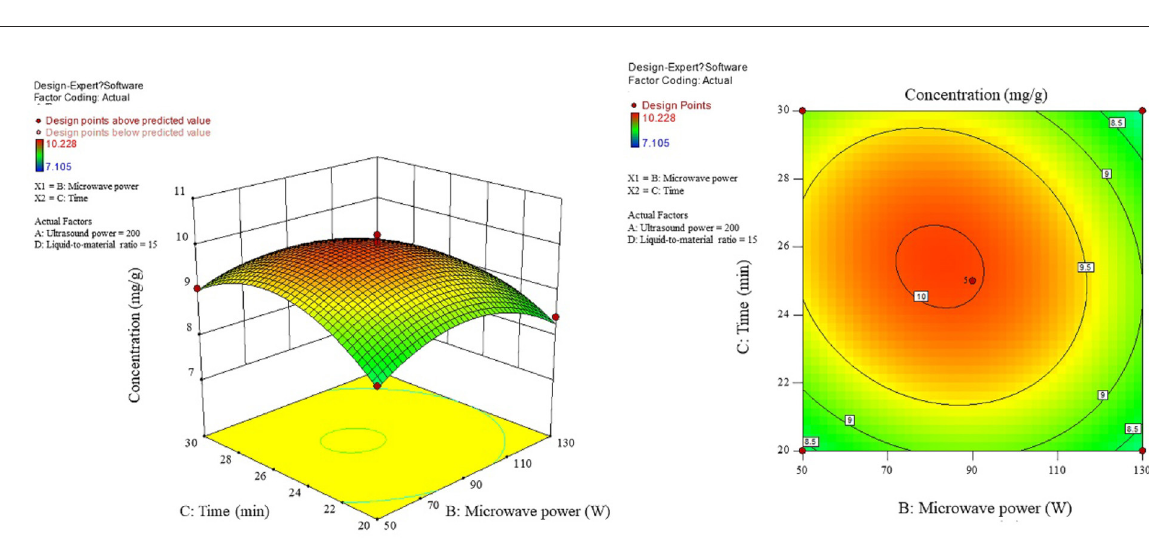
FIGURE6 Effect of the interaction of microwave power and extraction time on